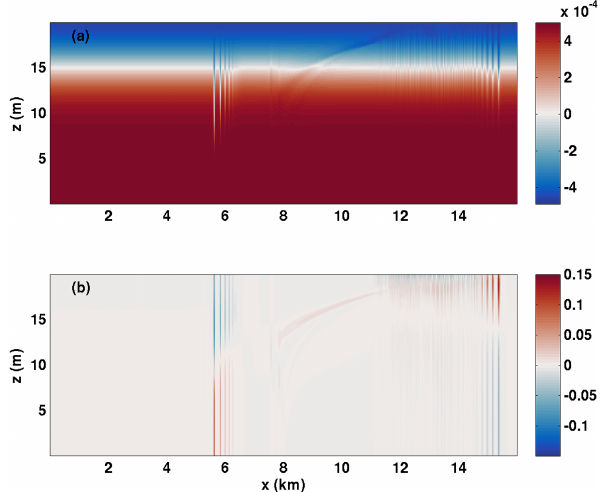
Figure 3. Vertical component of the velocity shaded and saturated at ± 0 . 01ms − 1 and eight density contours in black at t = 7200s for cases DJL and DJLB. (a) Case DJL leftward (against shear) prop- agating wave train and (b) Case DJL rightward (with shear) propa- gating wave train. (c) Case DJLB leftward (against shear) propagat- ing wave train and (d) Case DJLB rightward (with shear) propagat- ing wave train.